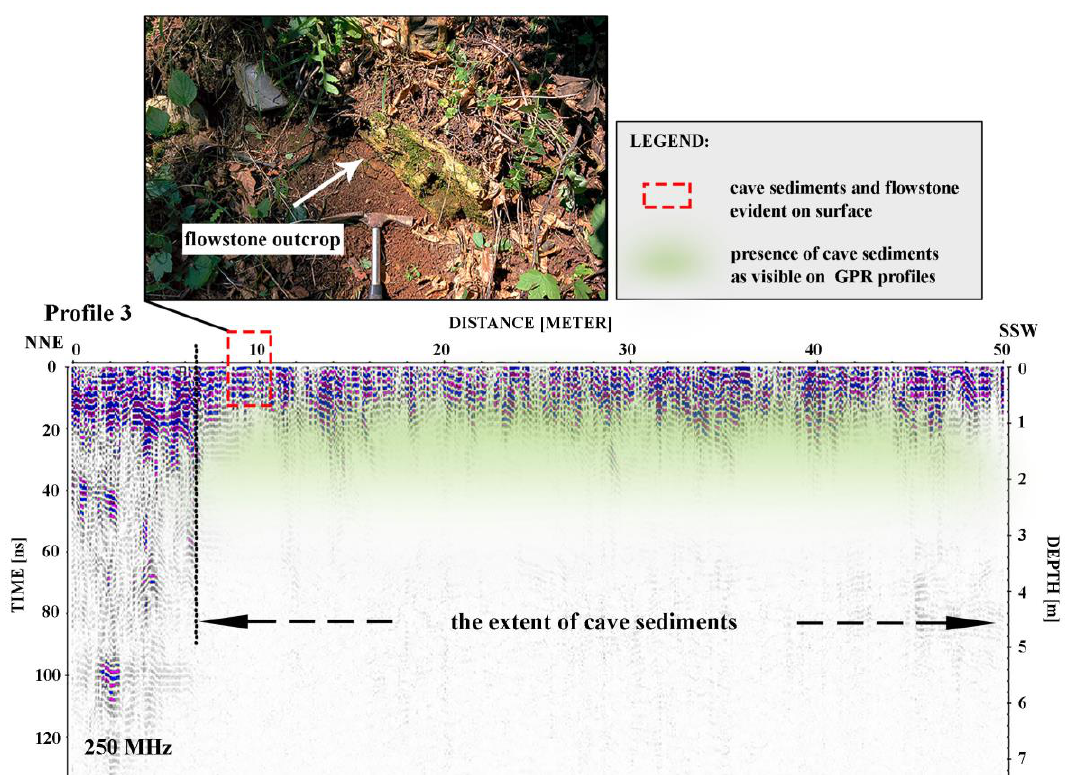
Figure 10. Radargram acquired with a 250 MHz antenna, where the spatial extent of cave sediments was revealed along Profile 3.